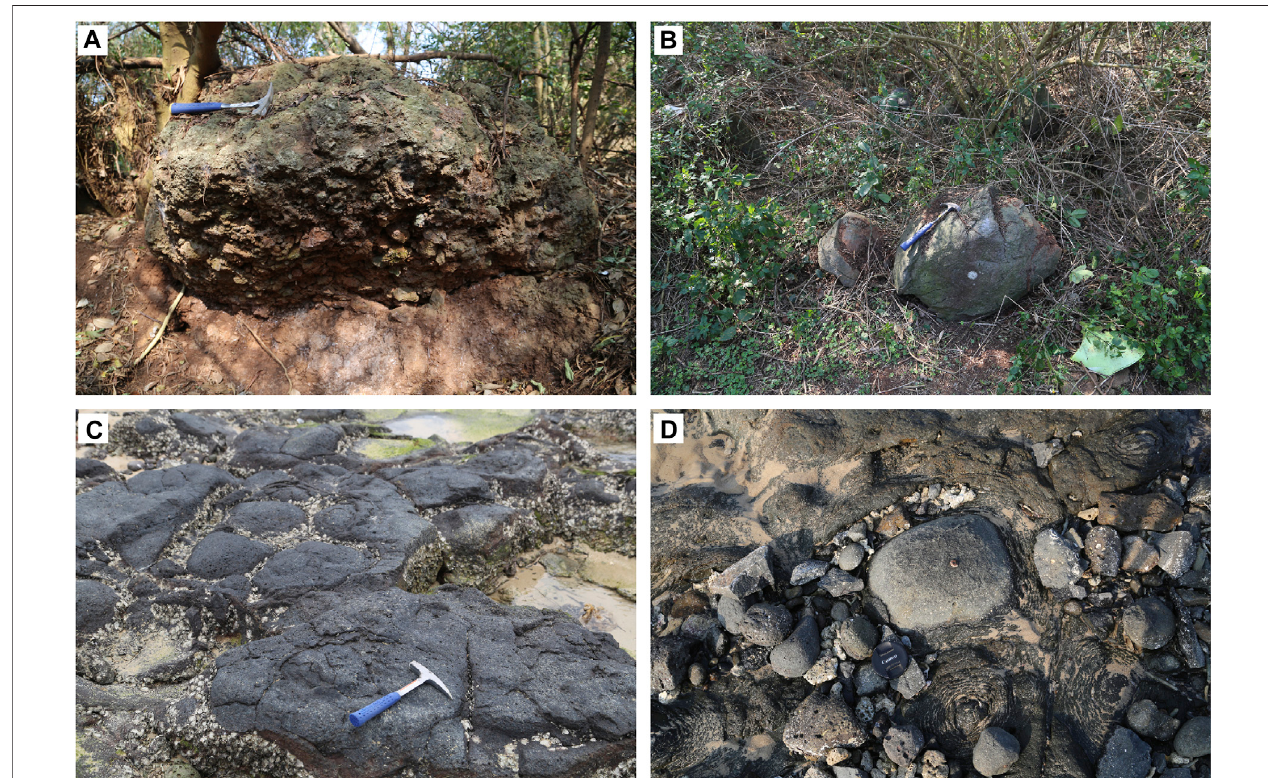
FIGURE 2 | Field photographs of volcanic products from Henglushan Volcano. (A) Welded agglomerates on the top of Guogailing at Henglushan. (B) Volcanic bomb with a diameter around 60 cm close to Guogailing. (C) Outcropping lava bodies in Xijiao intertidal zone. (D) Outcropping spheroidal weathered basalts in Xijiao intertidal